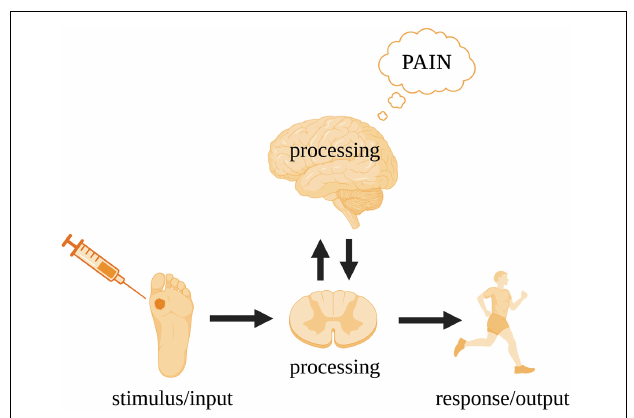
FIGURE 2 | Gross processing pathways underpinning the subjective experience of pain in humans. The spinal cord acts as a conduit for the noxious stimulus input and action output while the cerebral cortex executes the critical neural processing leading to pain (see Figure 3 for